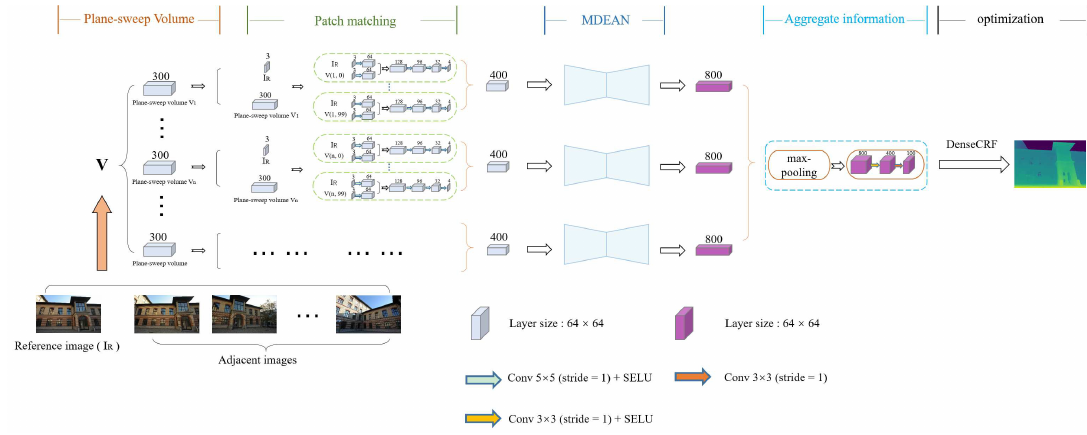
Figure 4. The overall structure of the network. We use three channel color images for disparity estimation. The maximum number of disparity levels is set to 100, the adjacent image is warp transformed to the reference image for each disparity level. Then the transformed layers are stacked to form a 300 layer volume that serves as input to the